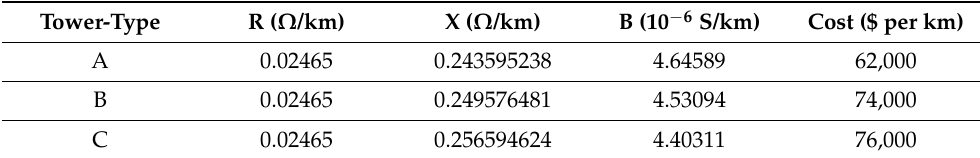
Table 6. The line parameters corresponding to different towers.